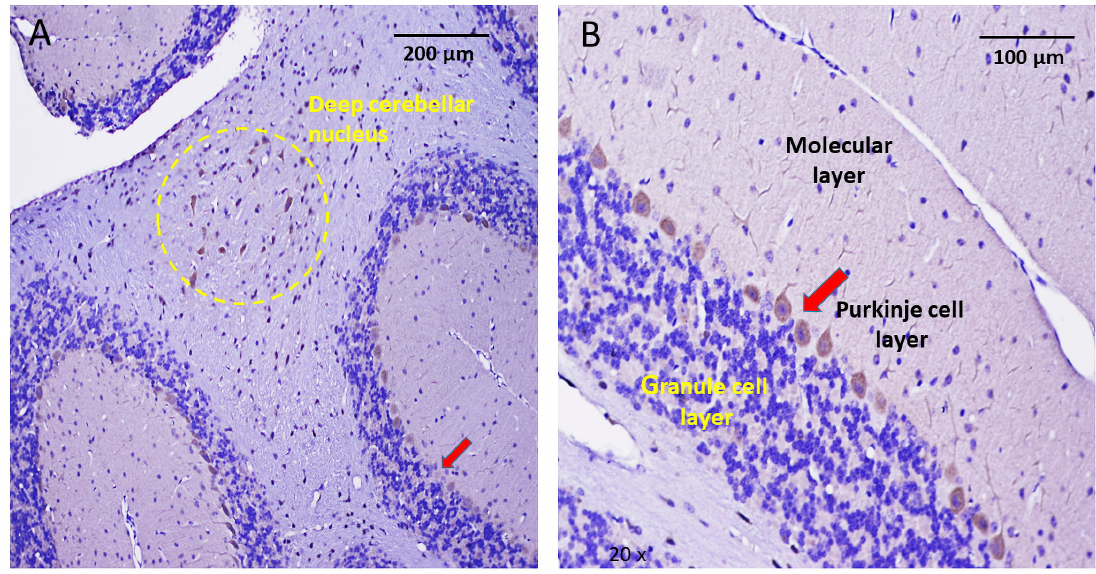
Fig. 5. Immunohistochemical localization of Piezo2 in the cerebellum. (A) Low magnification of a cerebellar slice indicating the stained Purkinje cell layer (red arrow) that separates the granule and molecular cell layers. The yellow dashed circle within cerebellar white matter (arbor vitae) encloses a group of stained neurons, presumably part of a deep cerebellar nucleus. (B) Higher magnification of the cerebellar cortex showing the characteristic single layer of Purkinje cells, which appear uniformly stained by the anti-PIEZO2 Ab. In contrast to the stained Purkinje cells, the more numerous granular cells within the granular cell layer were not stained. Similarly, apart from Purkinje cell dendrites, there was no pronounced Ab staining of cells within the molecular